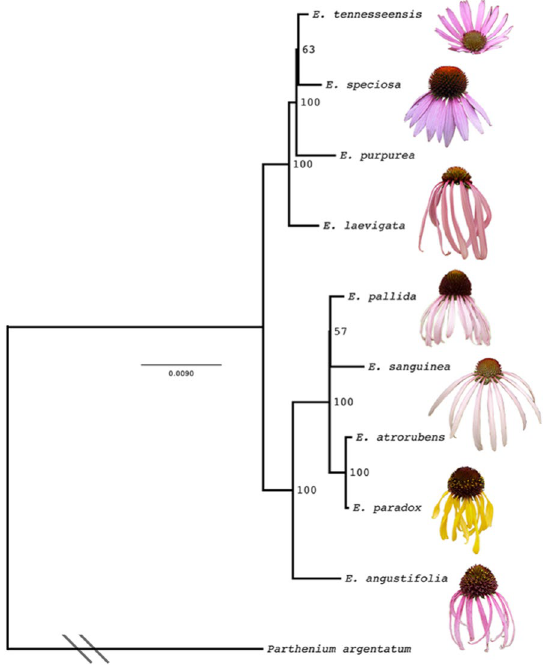
Figure 2. The ML tree of Echinacea reconstructed using chloroplast genomes. Numbers on branch nodes are bootstrap values. The branch connecting the outgroup Parthenium argentatum and nine Echinacea species was collapsed.